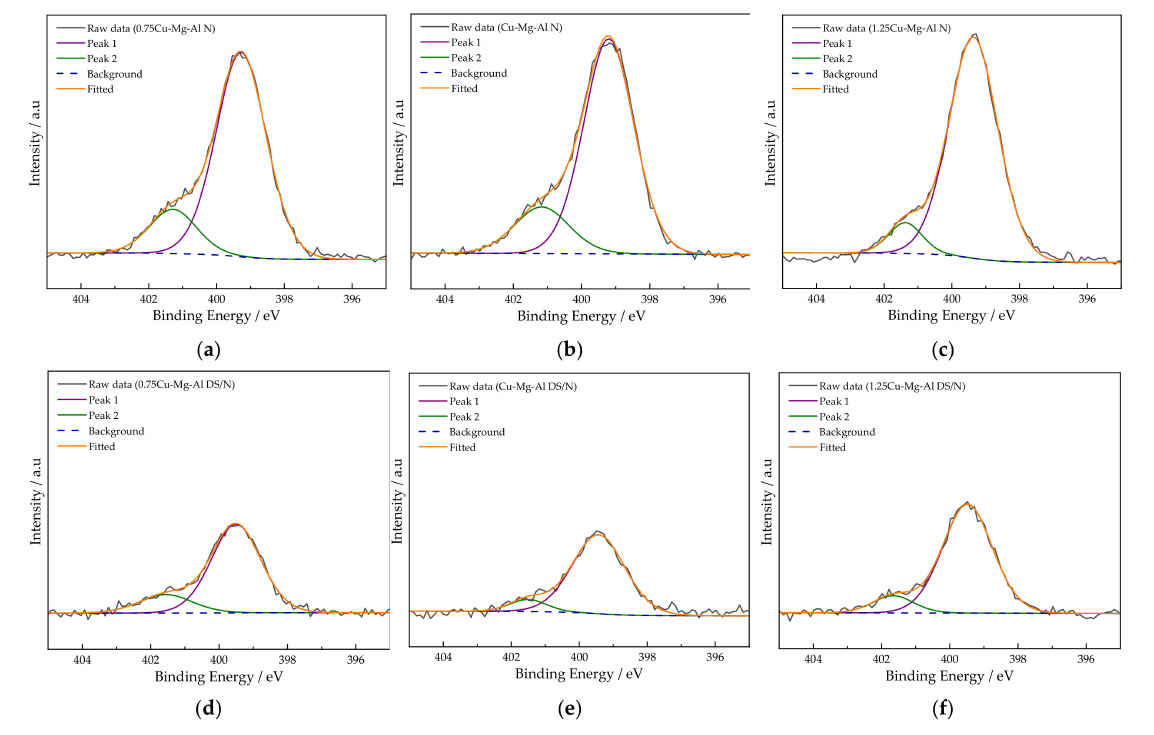
Figure 5. The high-resolution spectra of N 1s of xCu-Mg-Al DS/N and xCu-Mg-Al N: ( a ) 0.75Cu- Mg-Al N; ( b ) Cu-Mg-Al N; ( c ) 1.25Cu-Mg-Al N; ( d ) 0.75Cu-Mg-Al DS/N; ( e ) Cu-Mg-Al DS/N; ( f ) 1.25Cu-Mg-Al DS/N.